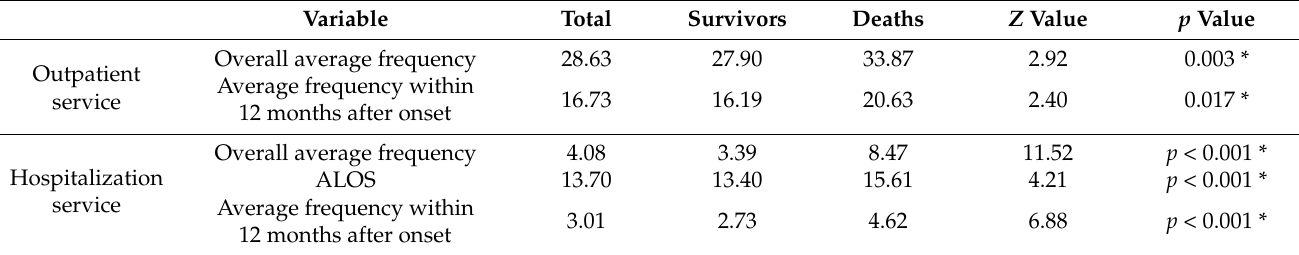
Table 2. Medical service utilization of cervical cancer cases from 2010 to